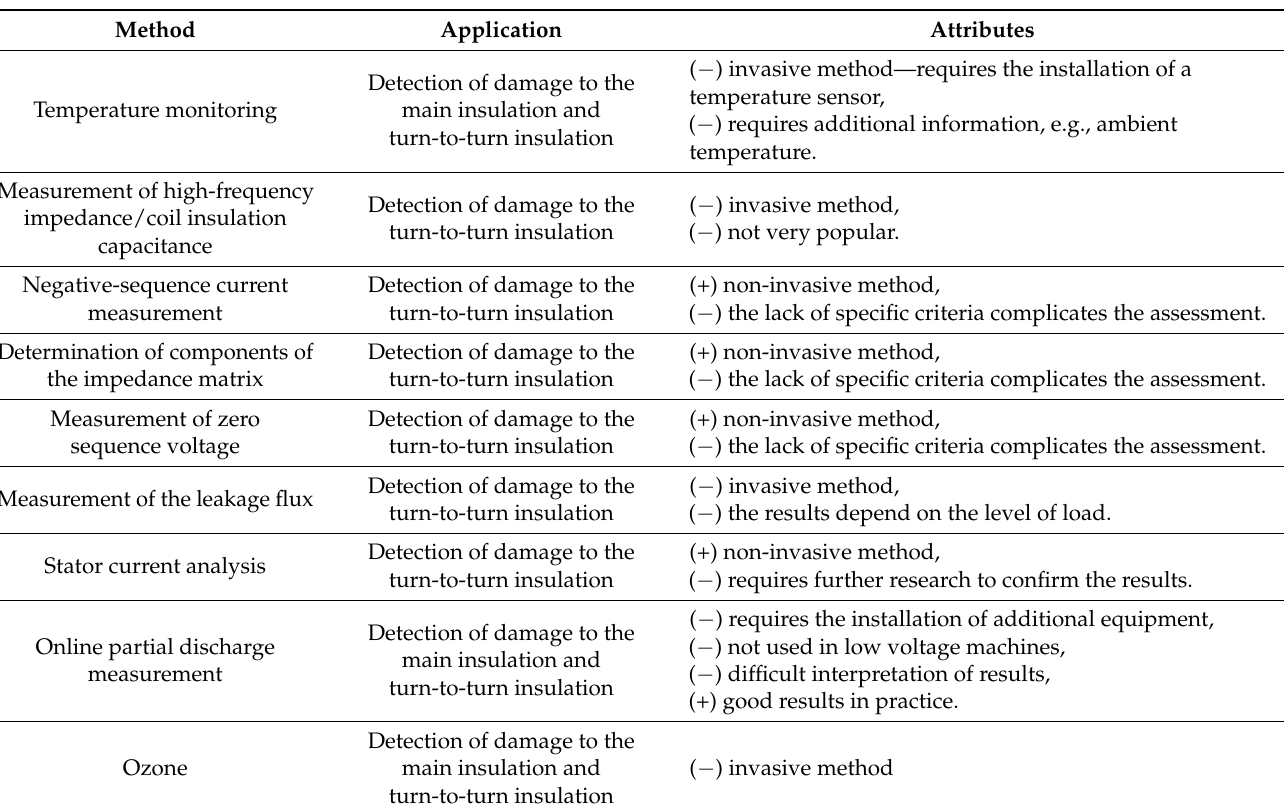
Table 9. Online diagnostic methods of the insulation